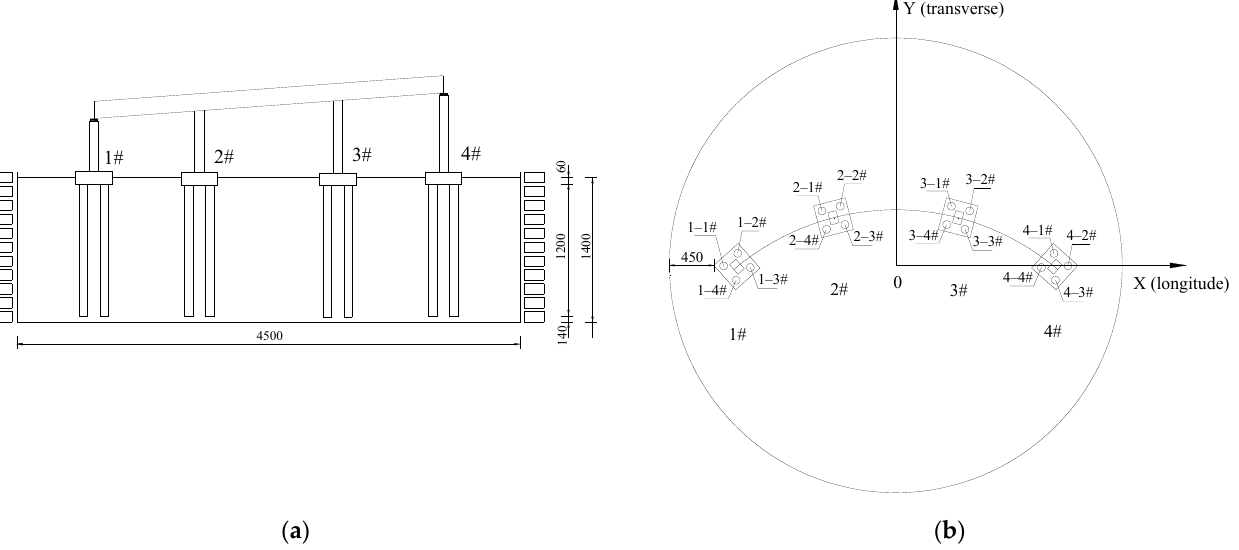
Figure 1. Layout of the shaking table test.